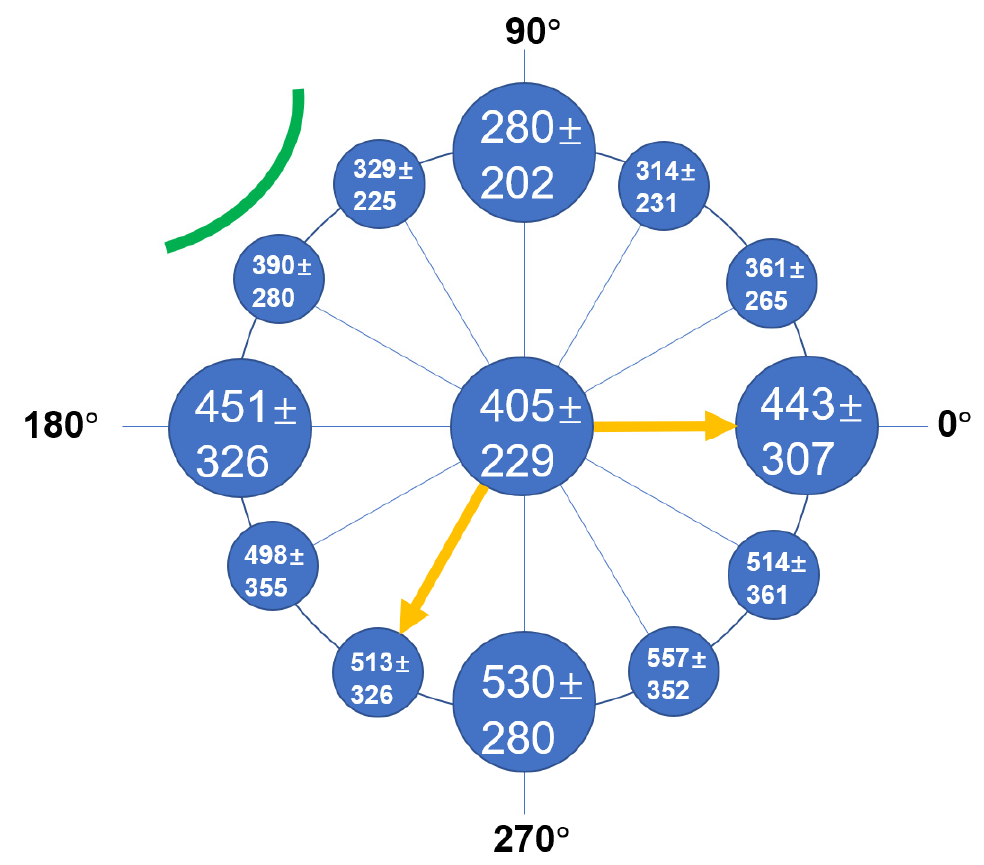
Figure 3. The mean ± standard deviation (SD) width of Berger’s space at three points (as illustrated in Figure 2) at each meridian line. The green curved line indicates the main clear corneal incision for the phacoemulsification tip. The region indicated by the two yellow arrows represents the main impact area of irrigation fluid during cataract surgery. The mean width of Berger’s space opposite to the main clear corneal incision was the largest, which impacted the influence of irrigation fluid circulations.